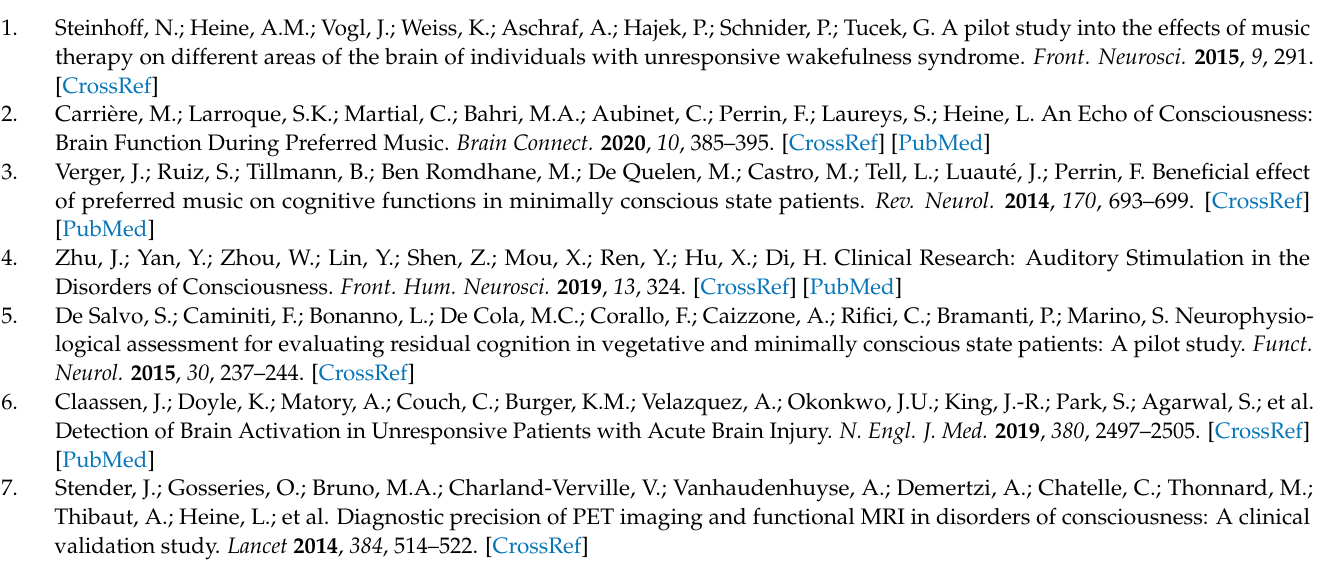
Figure A4. Boxplot showing, on the y -axis, the ratio of LFO power (low-frequency oscillation) for O2HB calculated using alternative low-pass filters (0.3 and 0.2 Hz) to identify the LFO spectral region. On the x -axis, the subsequent experimental blocks are shown: (m1/b1) from the first baseline to the first music period; (b2/m1) from the first music period to the second baseline; (b2/m2) from the second baseline to the second music block; (b3/m2) from the second music block to the third baseline. The same patterns of change previously observed with the original bandpass filter (0.4–0.04) are still observed. ( A , B ) Ratios of LFO power (here defined by a bandpass filter of 0.3–0.04 Hz) power in the left ( A ) hemisphere and ( B ) right hemisphere. ( C , D ) Ratios of LFO power (here defined by a bandpass filter of 0.2–0.04 Hz) in the right ( C ) and left ( D )